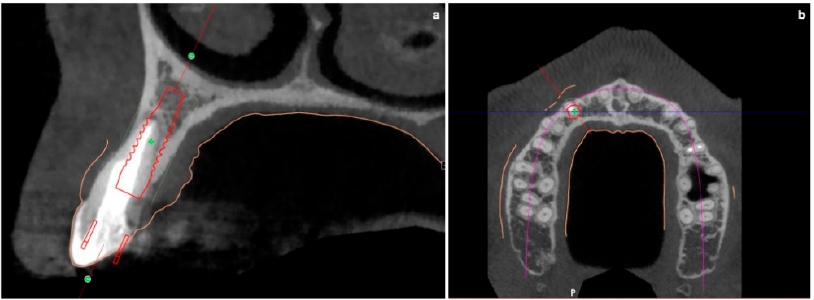
Figure 3. ( a , b ) Pre-surgical CBCT evaluation in order to perform guided implant insertion.